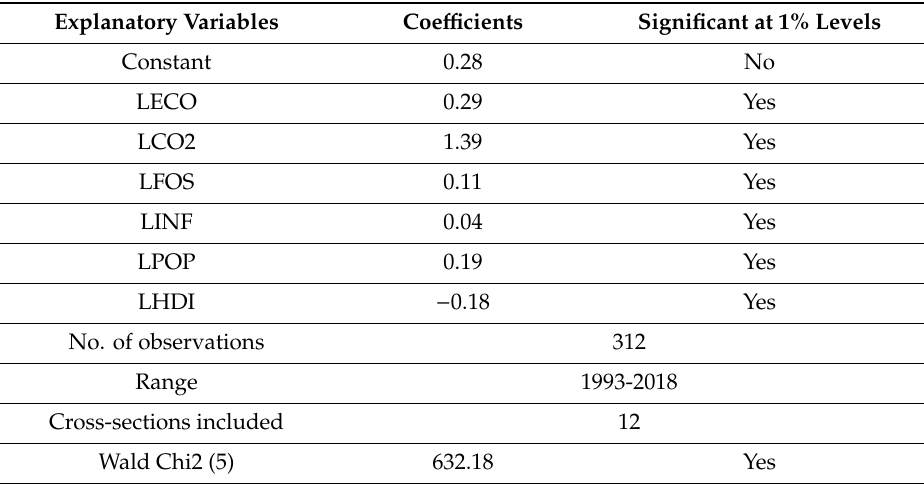
Table 3. Generalized method of moments (GMM) estimation